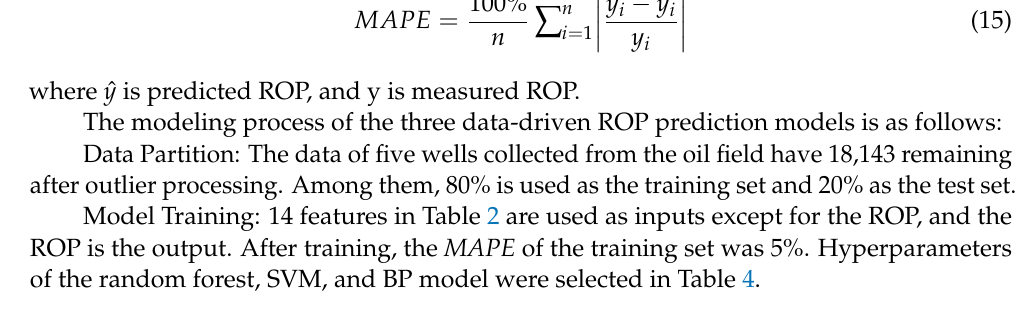
Table 4. Superparameter of the ROP prediction data-driven